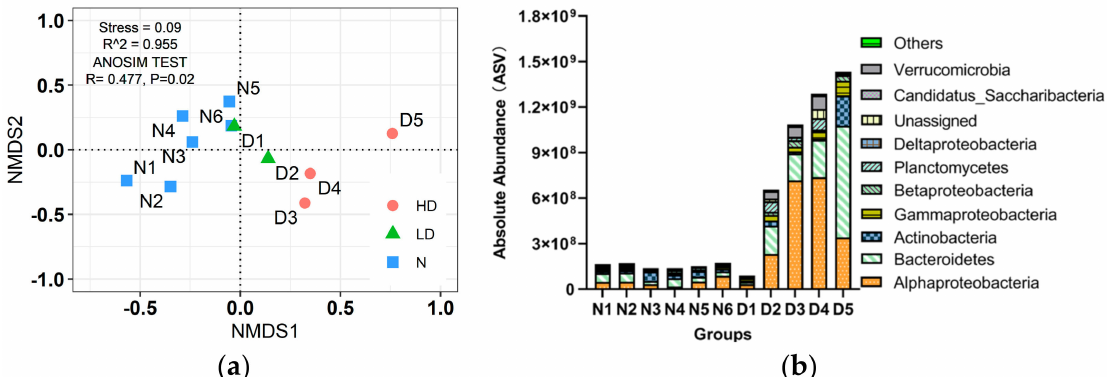
Figure 3. ( a ) Non-metric multidimensional scaling (NMDS) ordination of bacterial communities of all taxa, showing the differences of bacterial communities among 11 experimental treatments, which could be divided into three categories: “N” represents groups with different nutrient levels (i.e., N1~N6), “LD” represents groups with low dosages of NaClO (i.e., D1 and D2), “HD” presents groups with high dosages of NaClO (i.e., D3~D5). ( b ) Changes in the abundance of dominant phyla (>0.5%) among 11 treatments. The phylum Proteobacteria was subdivided into the class